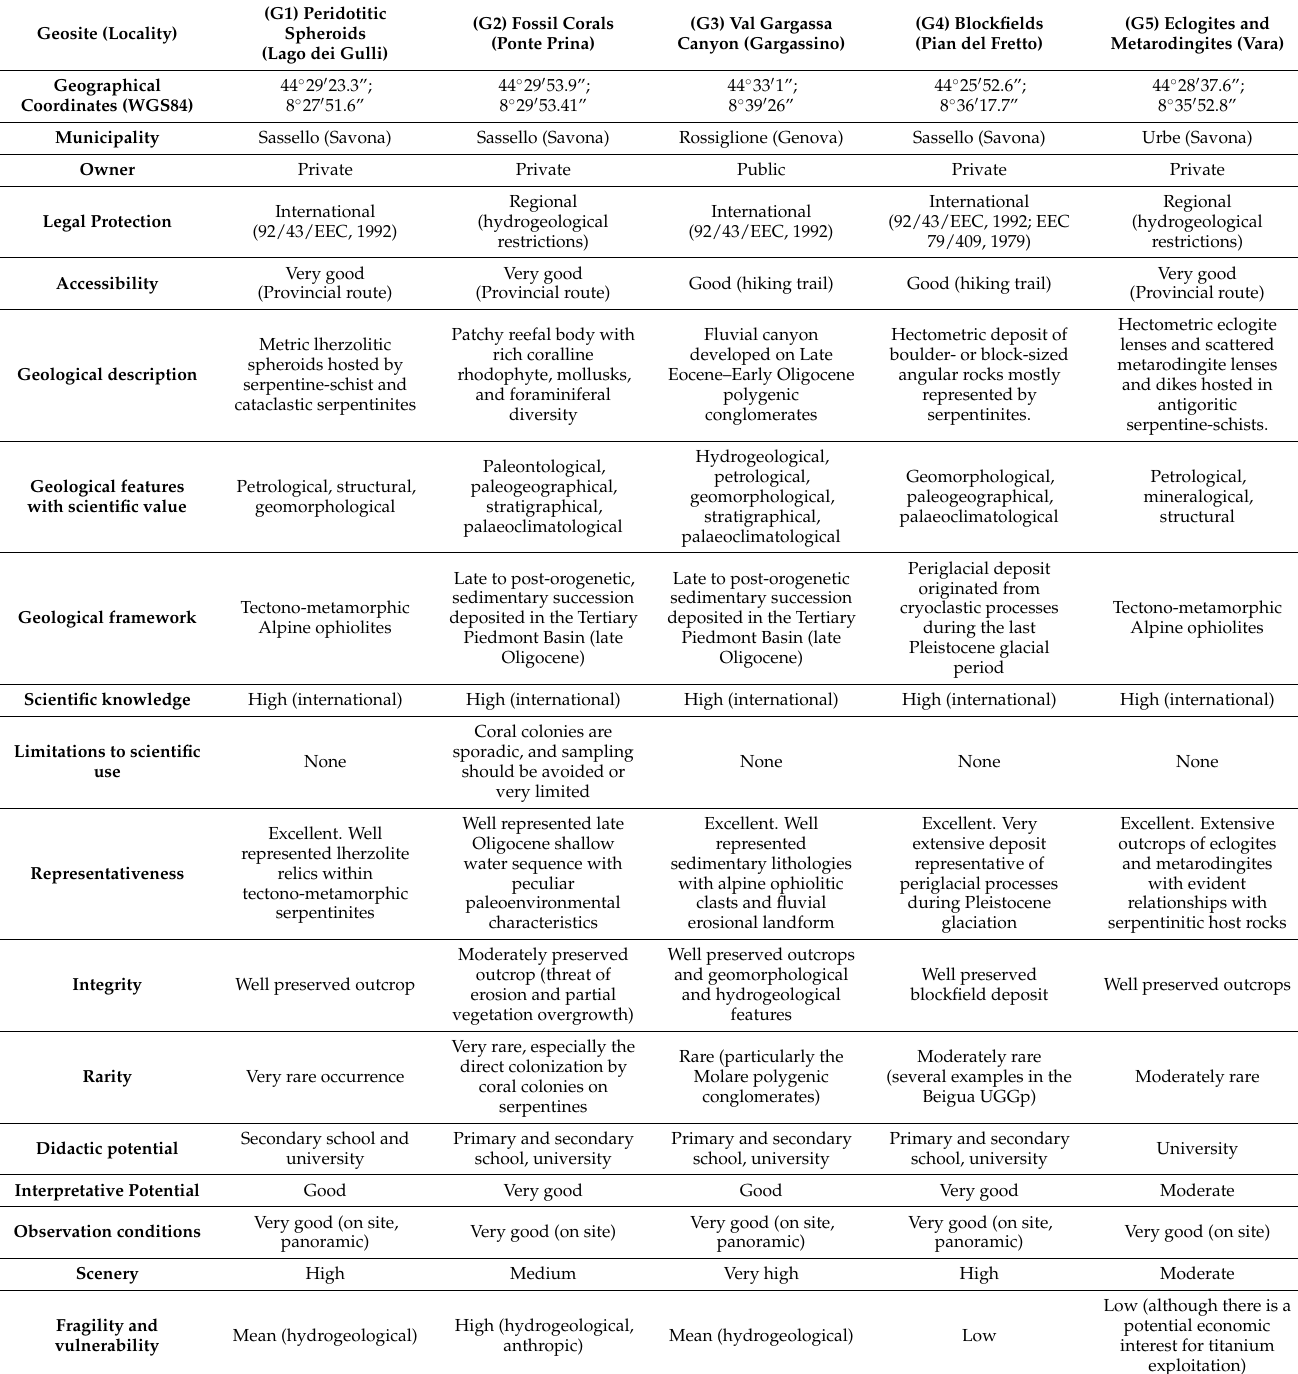
Table 1. Inventory and qualitative assessment of selected geosites (G) from Beigua UGGp included in the Italian inventory by ISPRA [4] according to the criteria of Brilha (2016)